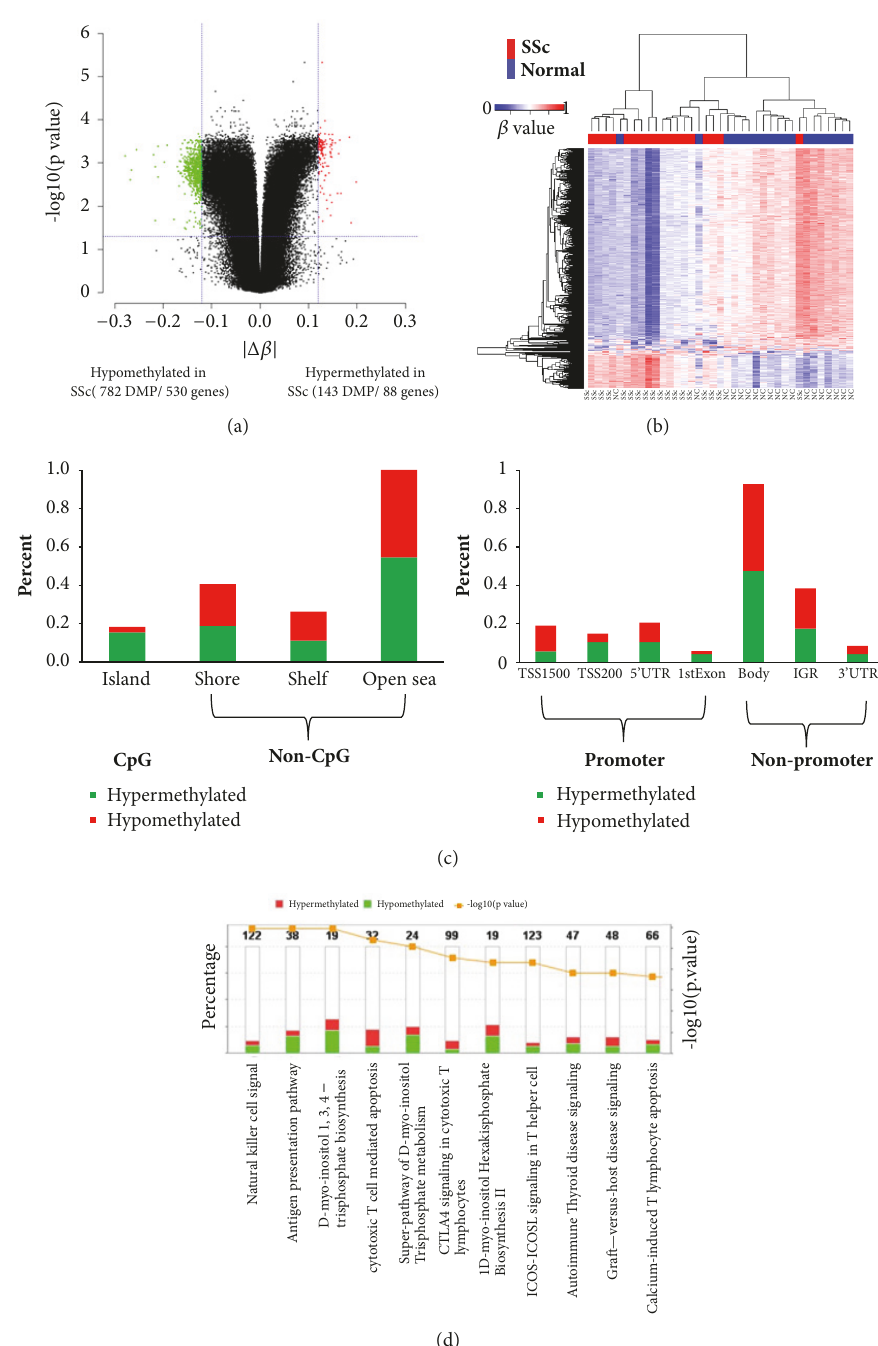
Figure 2: Identification of D NA methylation differences between systemic sclerosis and normal. (a) Volcano plot of the differential DNA methylation analysis. X-axis: mean 𝛽 -value difference; y-axis: BH-adjusted p values for each probe (- log10 scale). The vertical dotted lines represent 12% change in 𝛽 -values. The horizontal dotted line represents the significant cutoff of p < 0.05. Seven genes, ANKFY1, FAM49B, GNG7, INPP5A, LAX, PITPNM2, and VOPP1, showed both significant hypermethylation and hypomethylation (see text and Supplementary Table 2). (b) Two-dimensional hierarchical clustering was performed using the differential Infinium DNA methylation probes across all samples (n = 37). Probes are in rows; samples are in columns. (c) Proportions of probes from genes with associated CpG islands, shelf, shore, and open sea (left) and proportions of probesfrom genes with associatedprobelocations, categorized as genebody, intergenic,3’UTR, 5’UTR, 1 st exon, TSS1500, and TSS200 (right). (d) Canonical pathway analysis of the differentially expressed genes in PBMC from SSc patients as compared with normal controls. Statistically significant pathways were shown. The 1 st y-axis indicates percentage of differential expression genes involved in the pathway. The 2 nd y-axis shows BH-adjusted p-value of enrichment